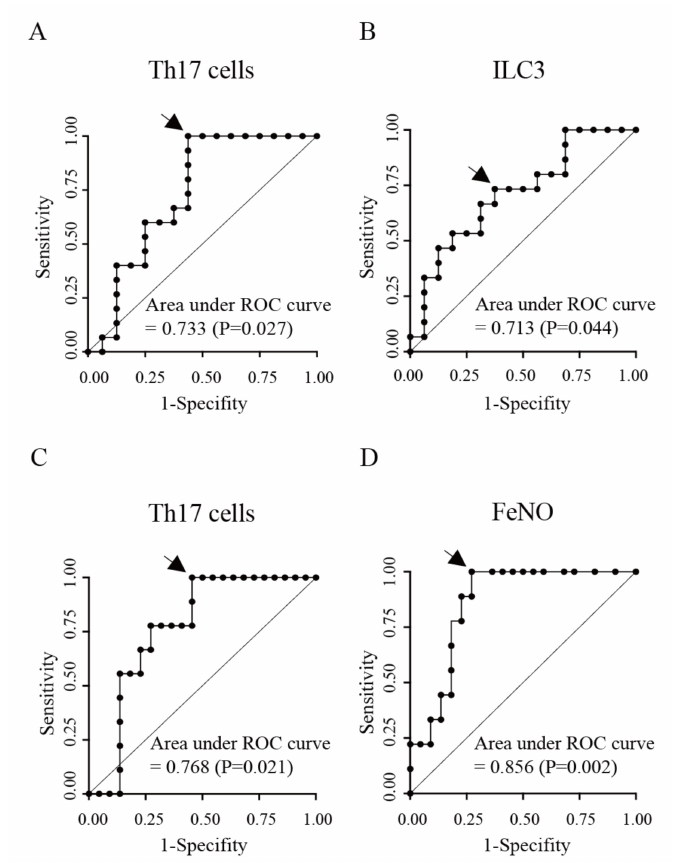
Figure 3. ROC curve for predicting responders ( A , B ) and patients achieving super-responders ( C , D ) to benralizumab treatment in patients with severe asthma. The cut-off values for frequency of Th17 cells of 4.57% Th cells ( A ) (sensitivity, 100%; specificity, 56.3%) and ILC3 of 11.45% ILCs ( B ) (sensitivity, 73.3%; specificity, 62.5%) to discriminate responders from non-responders are indicated with arrows. The cut-off value for FeNO levels of 44.0 ppb ( C ) (sensitivity, 100%; specificity, 72.7%) and the frequency of Th17 cells of 4.77% Th cells ( D ) (sensitivity, 100%; specificity, 54.6%) to discriminate super-responders from non-super-responders are indicated with